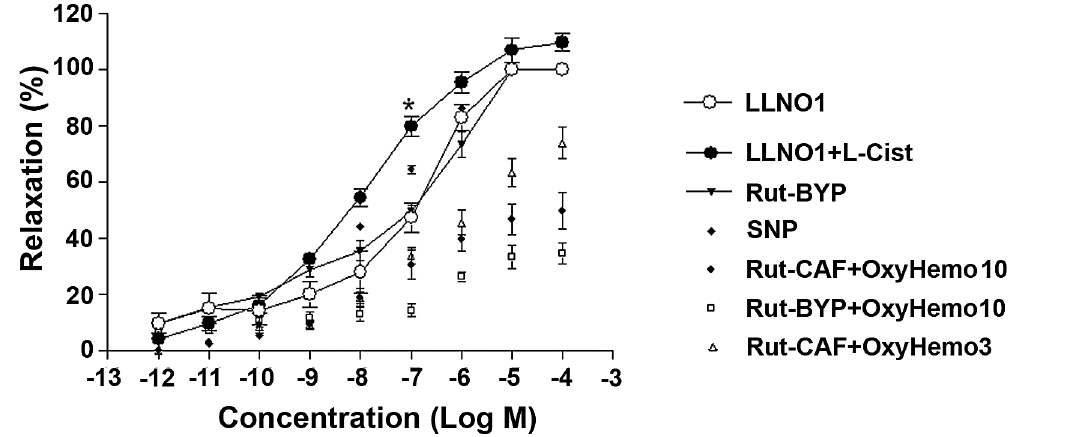
Figure 5 – Effect of LLNO1 and FONO1 alone and in combination with oxyhemoglobin or L-cysteine upon aortic vascular endothelium rings. The rings were precontracted with 1 µ M phenylephrine and relaxation concentration/response curves (concentrations graded from 10 -12 to 10 -3 M) were plotted for LLNO1 and FONO1 alone and in combination with 100 µ M L-Cyst or 3 µ M or 10 µ M oxyhemoglobin. Findings are expressed as average ± standard error, based on six experiments. * p < 0.05 vs. LLNO1 + 3 µ M or 10 µ M oxyhemoglobin. FONO1 + 10 µ M oxyhemoglobin (ANOVA followed by the Tukey-Kramer